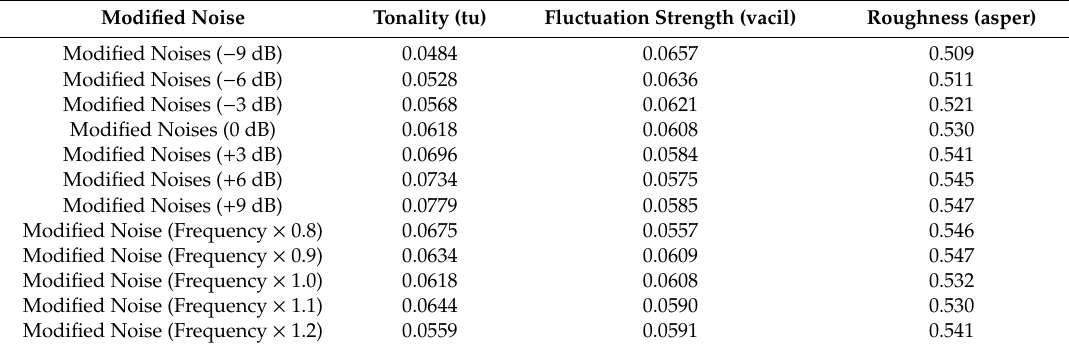
Table 9. Tonality of modified annular